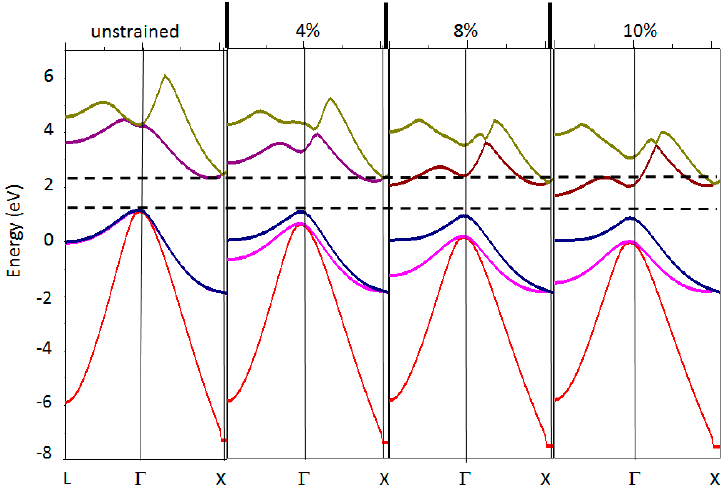
Figure 15. Band structure of silicon with increasing tensile strain of 4% ( ε = +0.04), 8% ( ε = +0.08), and 10% ( ε = +0.1). Only the two lowest conduction bands are shown. The blue, magenta, and red lines indicate the heavy hole, light hole, and split-off bands, respectively. The dotted lines indicate the band gap for unstrained silicon.